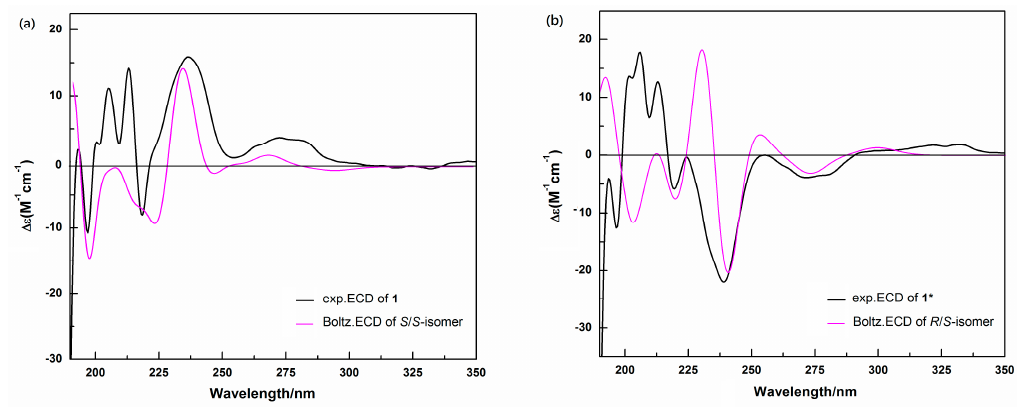
Figure 2. Experimental and calculated (TD-DFT/CAM-B3LYP/tzvp) ECD spectra of ( a ) 1 and ( b ) 1* .